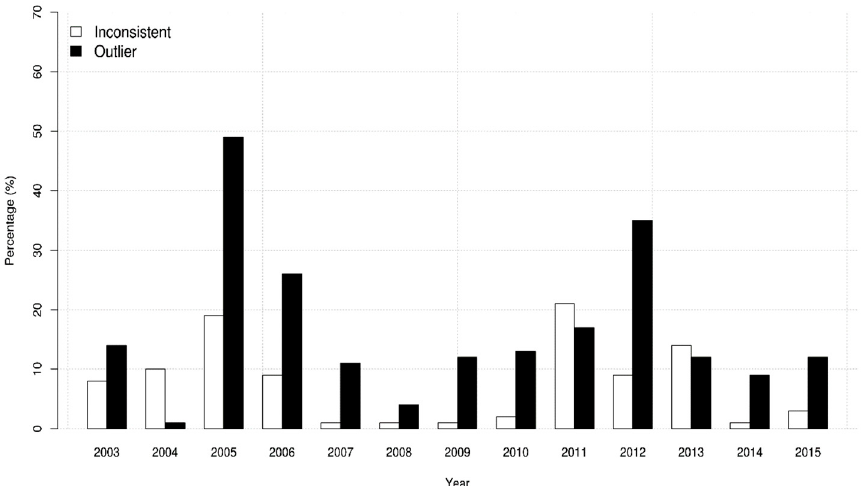
Figure 6. Annual percentages of inconsistent observations and of boxplot outliers in volunteered observations of lesser celandine flowering onset. Inconsistent observations are unusually early or late DOYs with respect to the regional temperature regime of the observation sites, while the outliers are only very early or late DOY.